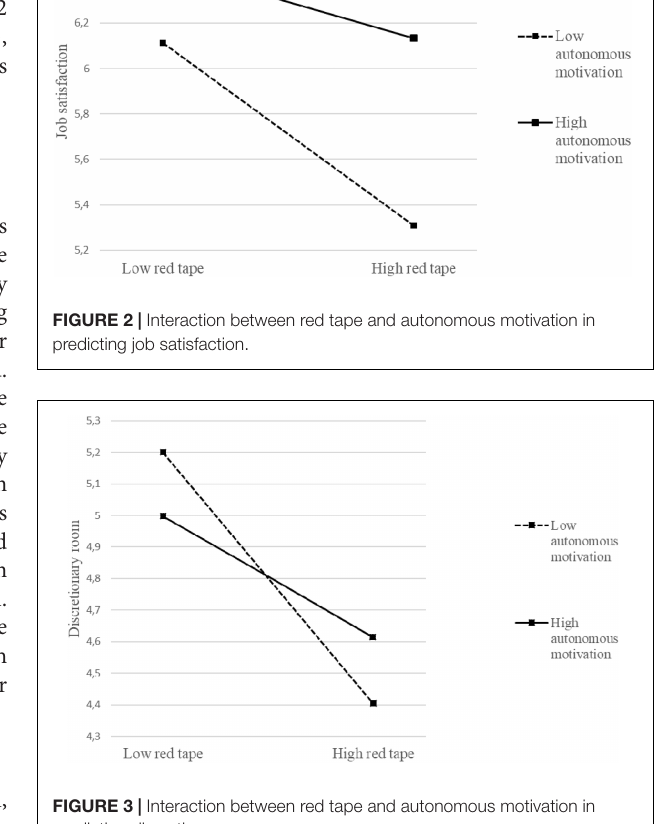
FIGURE 3 | Interaction between red tape and autonomous motivation in predicting discretionary